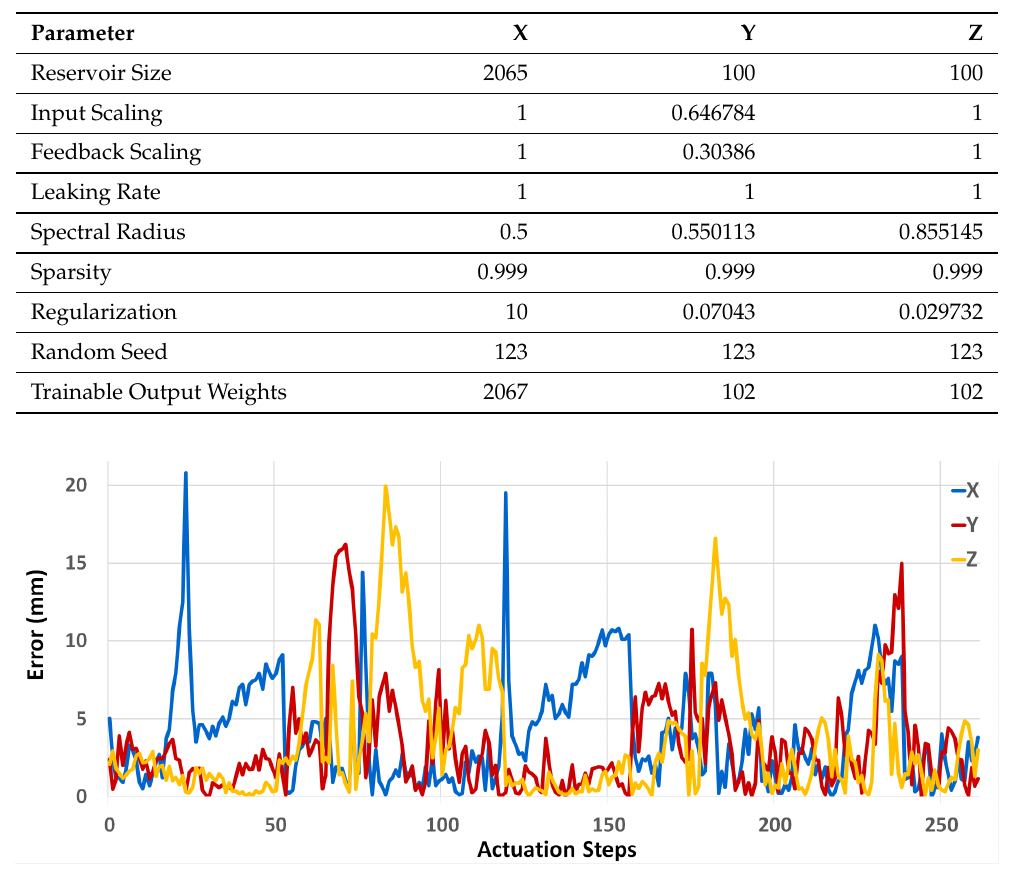
Figure 6. Prediction errors for optimized ESN. The error plot of the test sequences for the 3 motion axes x , y , and z